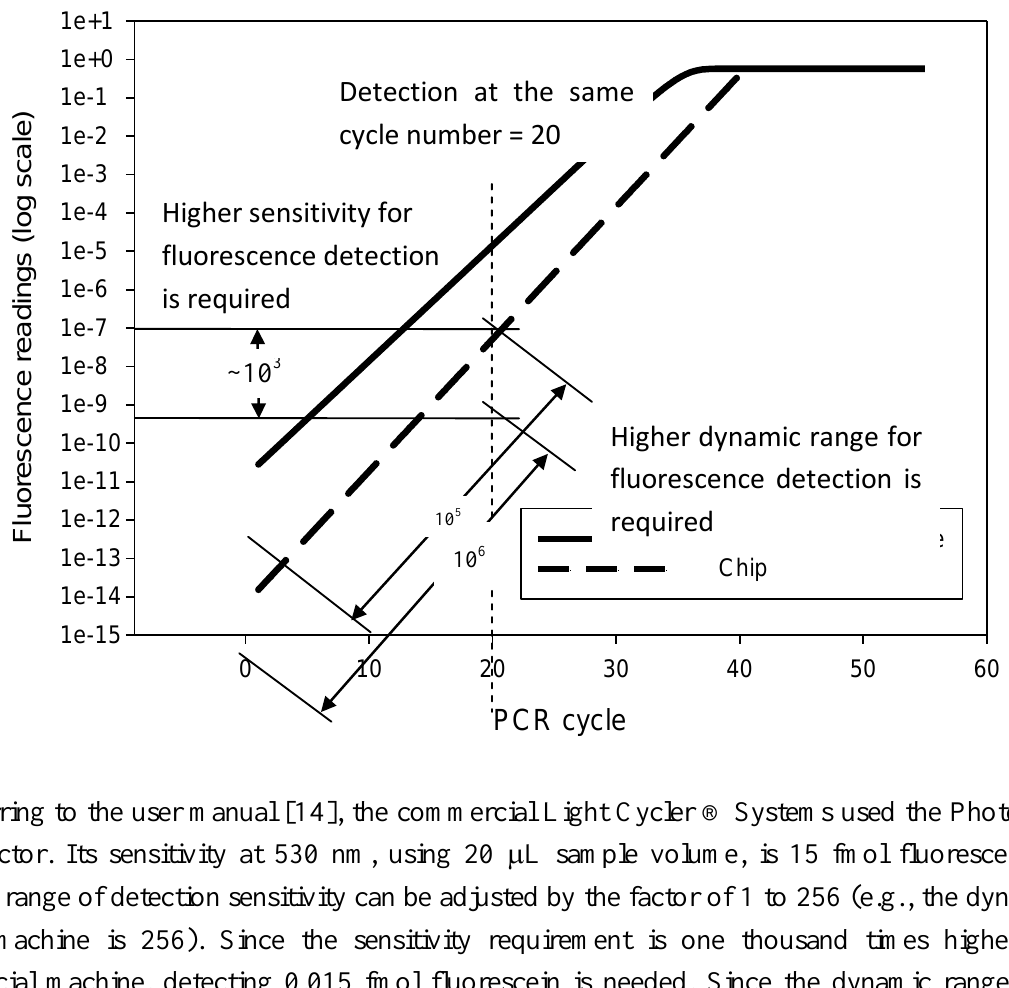
Figure 6. Simulated fluorescent intensities of chip and commercial machine with respect to PCR